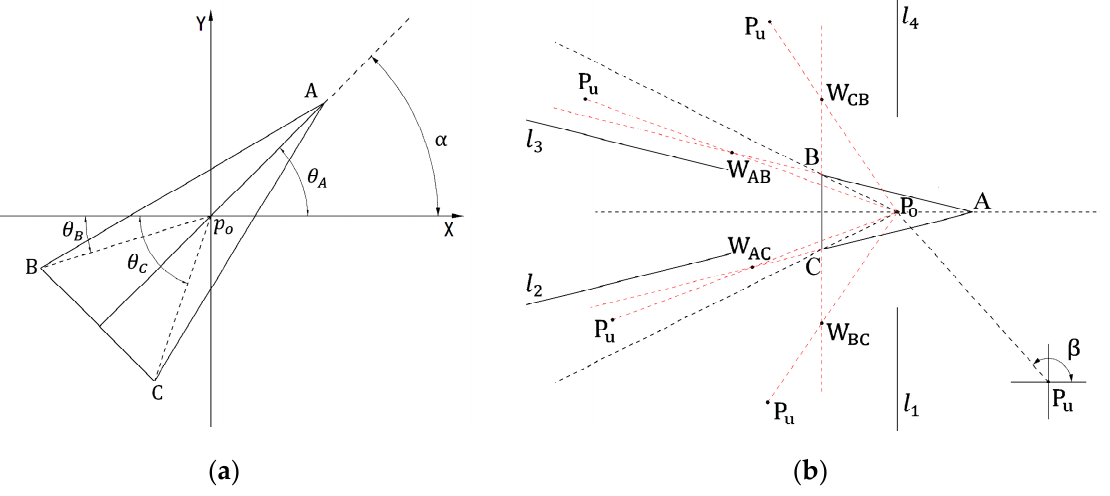
Figure 2. Schematic diagram of the selection of triangle vertices that form a relative collision area: ( a ) improved obstacle geometry region diagram; ( b ) vertex selection diagram of ray passing. The two vertices that make up the relative collision area of RCC uo are selected by the angle β ( 0 ≤ β ≤ 2 π ) between the center point P u of the USV and the center point P o of the obstacle and the direction angle α ( 0 ≤ α ≤ 2 π ) of the